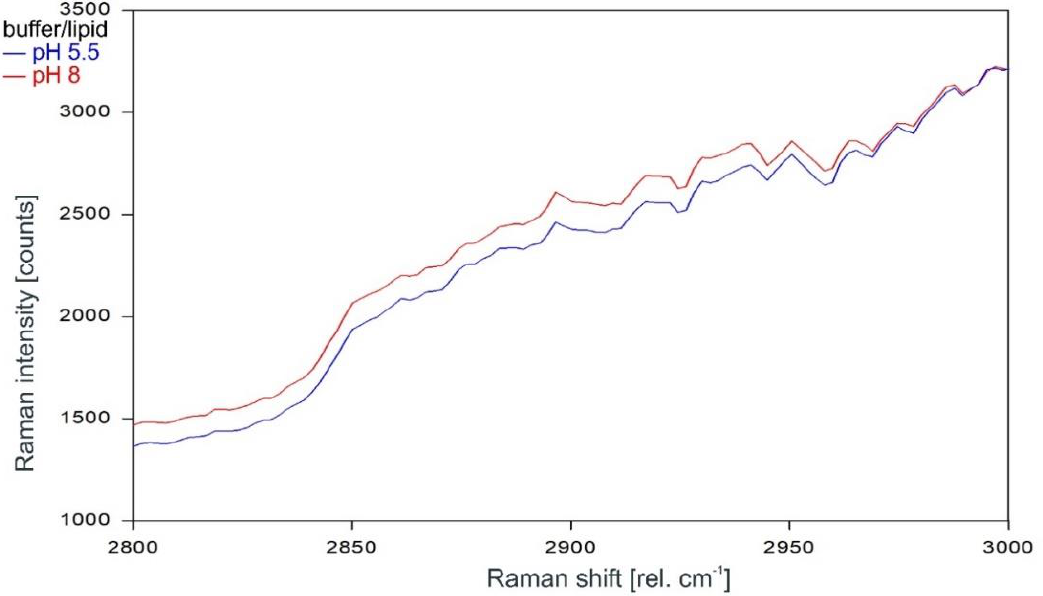
Figure 8. Raman spectrum of the buffer–lipid solution between 2800 and 3000 rel. cm −1 at pH 5.5 (blue) and pH 8 (red) as recorded.